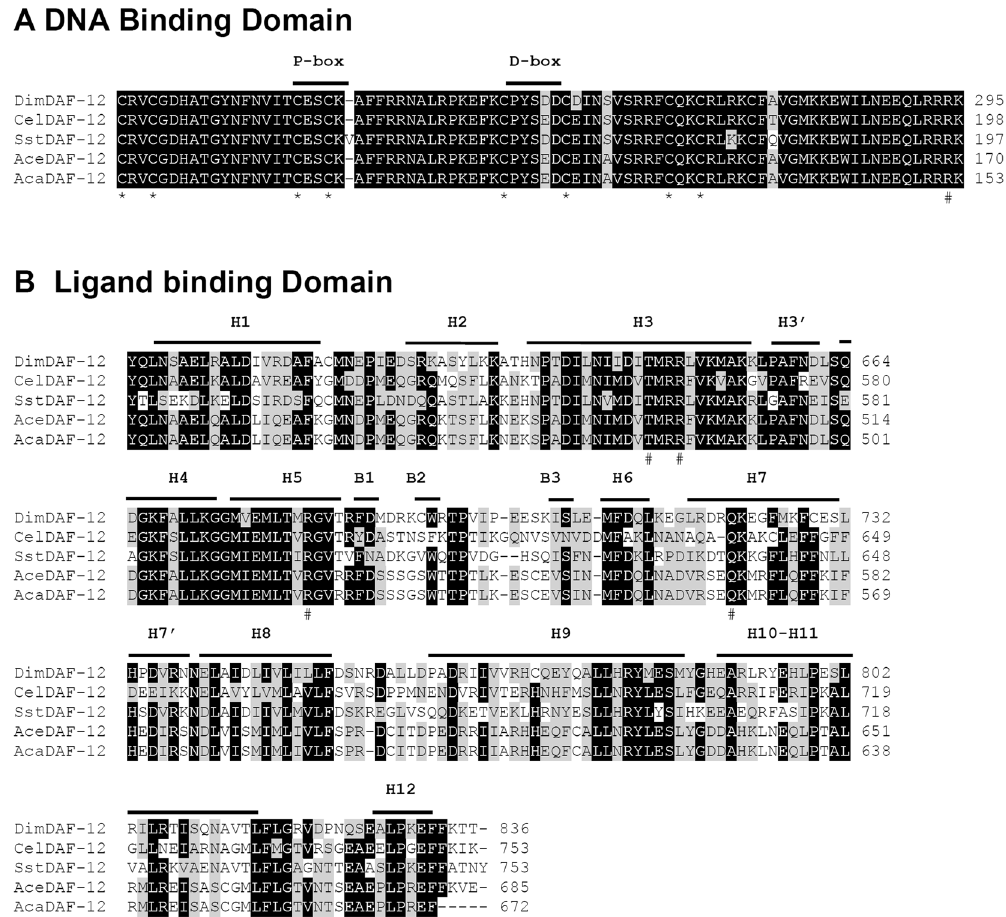
Figure 1. Alignment of DimDAF-12 protein with a subset of known DAF-12 receptors in nematodes. A Sequence alignment of the DBD of D. immitis (Dim; accession no. MK820661), C. elegans (Cel; NP_001024547), S. stercoralis (Sst; AAD37372), A. ceylanicum (Ace; EPB79655) and A. caninum (Aca; RCN38687). The cysteine residues involved in the coordination of zinc atoms are conserved and shown with an asterisk (*) below the sequence. The conserved arginine that is responsible for high affinity DNA binding is shown with a hash mark (#). P-box and D-box are underlined. B Sequence alignment of the LBD. The secondary structures delimited above the sequence are based on the crystal structure of SstDAF-12. H α-helix, B β-sheet. The residues that were previously shown as critical for the binding of dafachronic acids are indicated by hash marks (#) below the sequence. Amino acid residues are indicated on the right. Residues that are identical are highlighted in black and similar sequences in grey. Multiple sequence alignment was performed with BioEdit 7.2 ClustalW Multiple alignment (https ://bioed it.softw are.infor